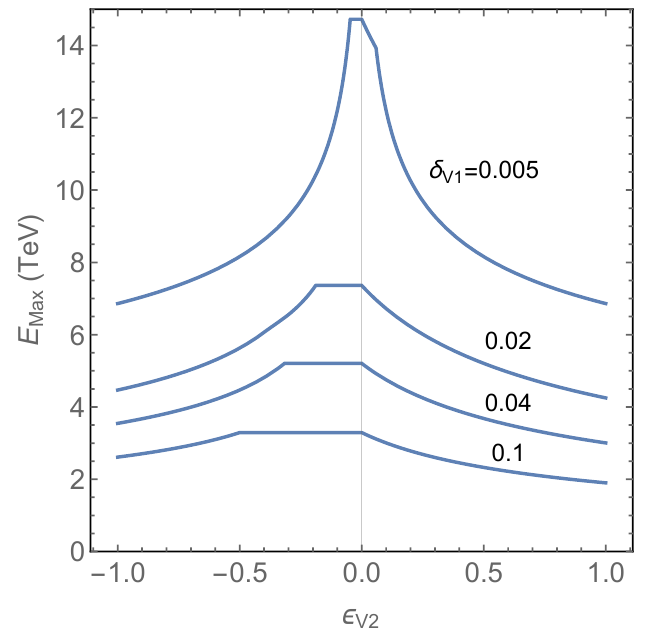
Figure 6 . Unitarity violating scales from processes that depend on δ V 1 and δ V 2 as a function of the fractional deviation of δ